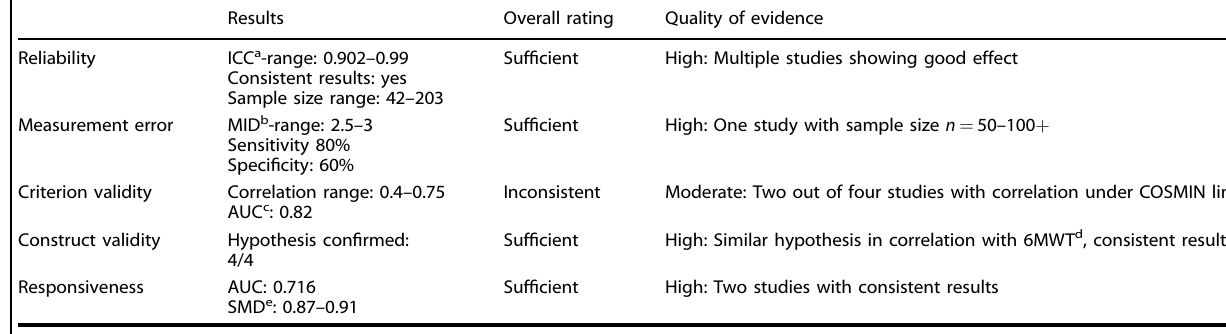
Table 1. COSMIN summary of evidence.